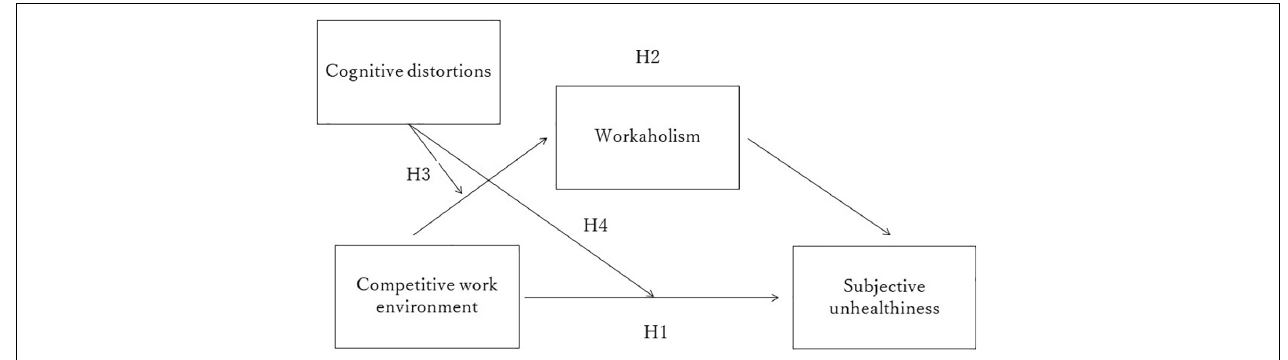
FIGURE 1 | The proposed model (Hypothesis